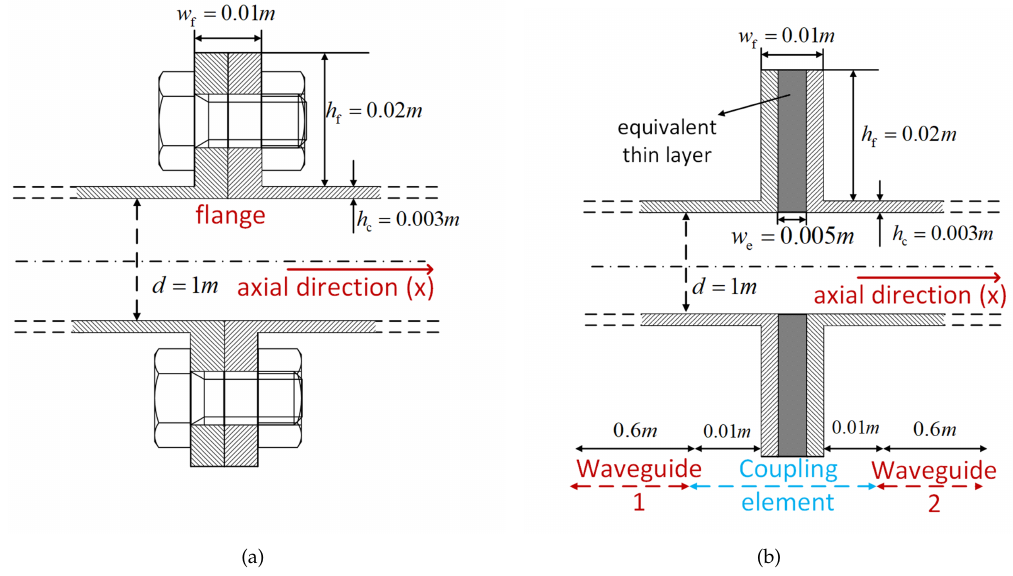
Figure 1. Drum-flange structure of an aero-engine. ( a ) section drawing; ( b ) simplified model with equivalent thin